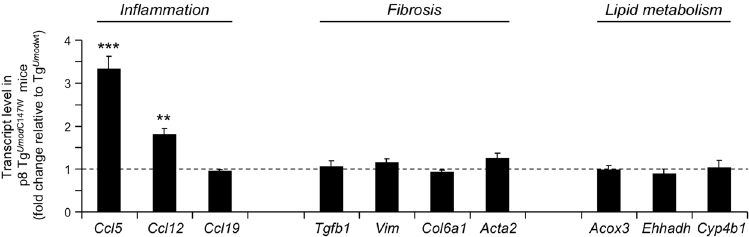
Figure 7. Expression level detected by RT-qPCR of genes involved in pathways of inflammation, fibrosis and lipid metabolism in kidneys of Tg Umod C147W mice at p8 relative to age- and sex-matched Tg Umod wt mice (n = 8 Tg Umod wt and 6 Tg Umod C147W ). Data are expressed as mean ± s.e.m. ** P < 0.01; *** P < 0.001 (unpaired t